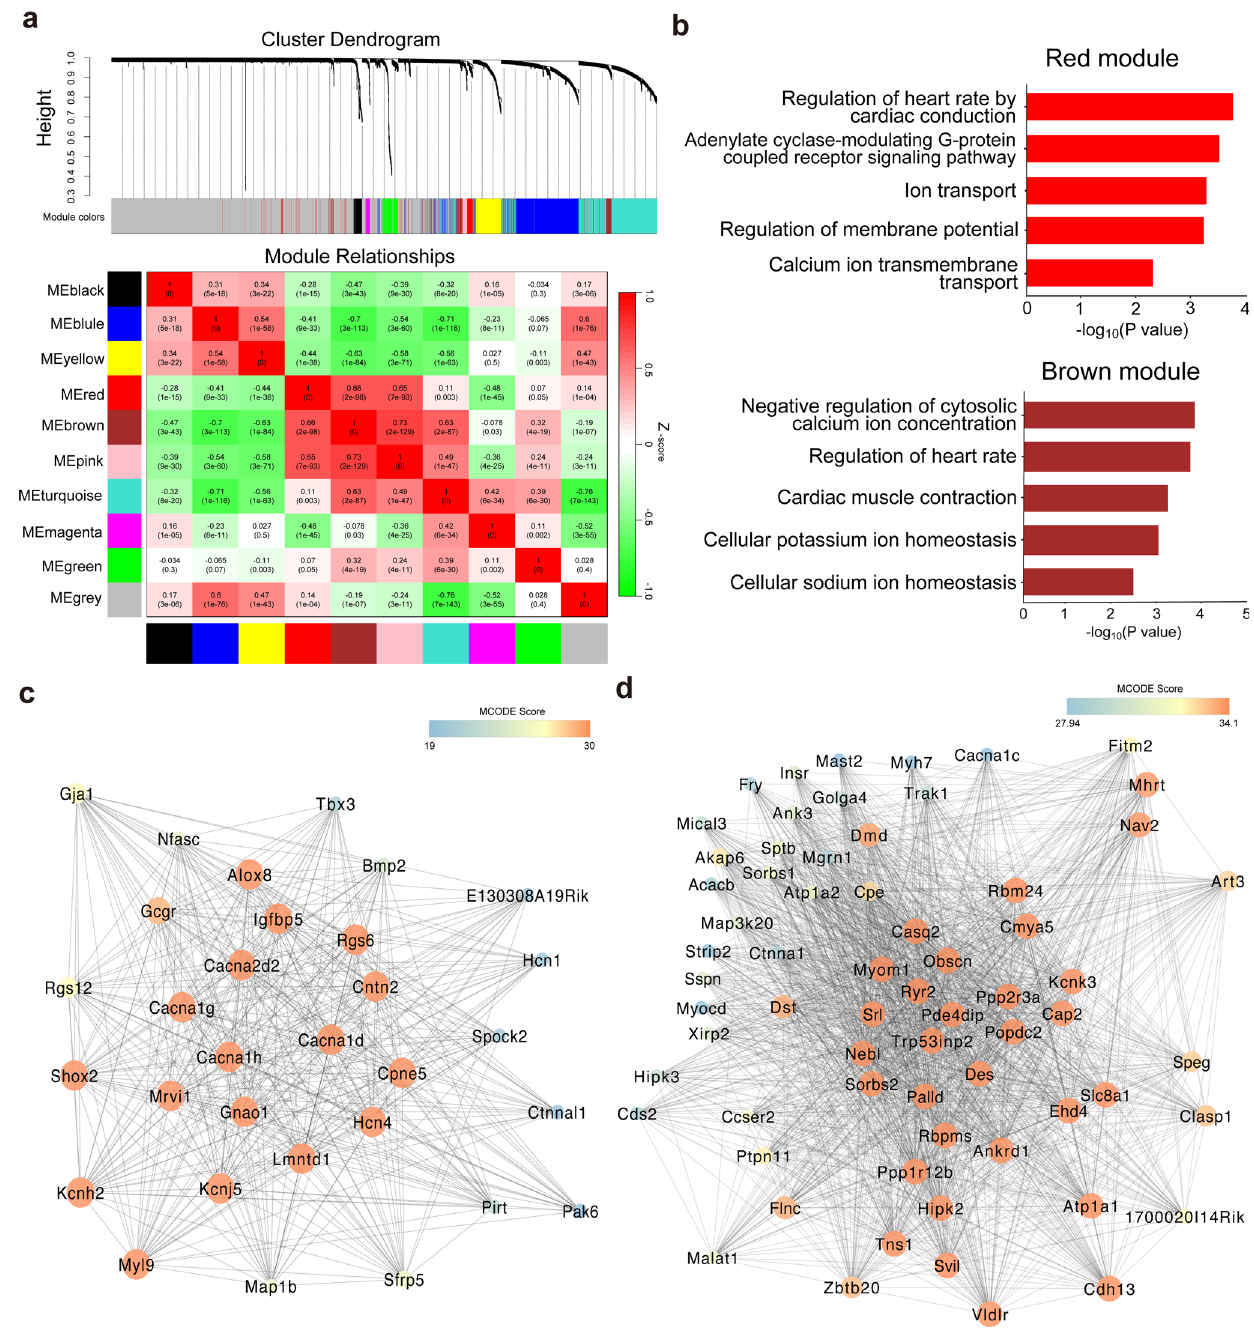
Fig. 5 Weighted gene co-expression network analysis (WGCNA) analysis of mouse sinoatrial node (SAN) cells. a The hierarchical cluster dendrogram identi fi es ten gene co-expression modules. Heat map shows the correlation of these modules. b Gene Ontology (GO) analysis shows that the main terms of red and brown modules were all related to SAN pacemaker activity. c Co-expression network of red module genes mainly focus on K + and Ca 2 + channels. d Co-expression network of brown module genes mainly focus on Ca 2 + regulators. The networks were created by Cytoscape and the high MCODE score of genes was mapped to the bright color of